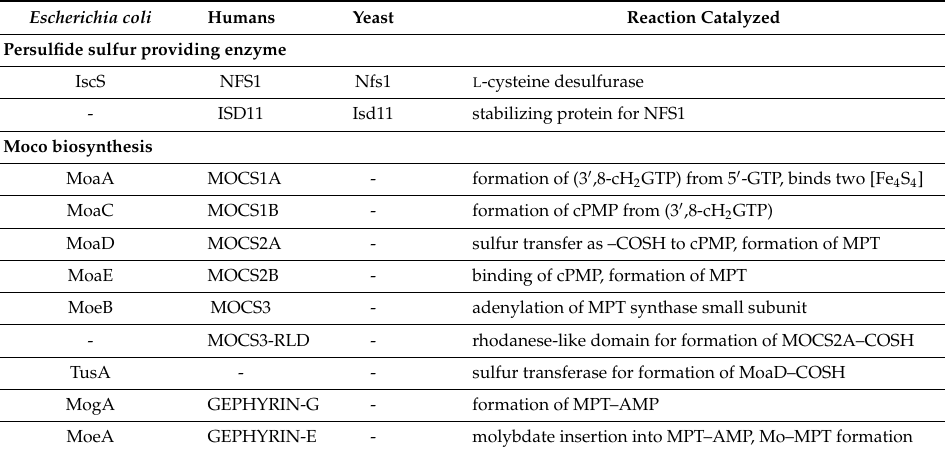
Table 1. Overview of the reactions catalyzed by proteins for molybdenum cofactor (Moco) biosynthesis and transfer (tRNA) thiolation in bacteria, humans and